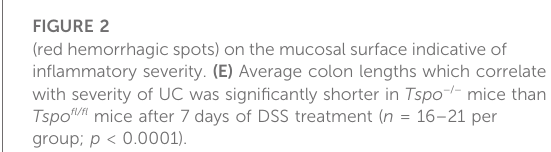
FIGURE 2 (red hemorrhagic spots) on the mucosal surface indicative of in fl ammatory severity. (E) Average colon lengths which correlate with severity of UC was signi fi cantly shorter in Tspo − / − mice than Tspo fl / fl mice after 7 days of DSS treatment ( n = 16 – 21 per group; p <